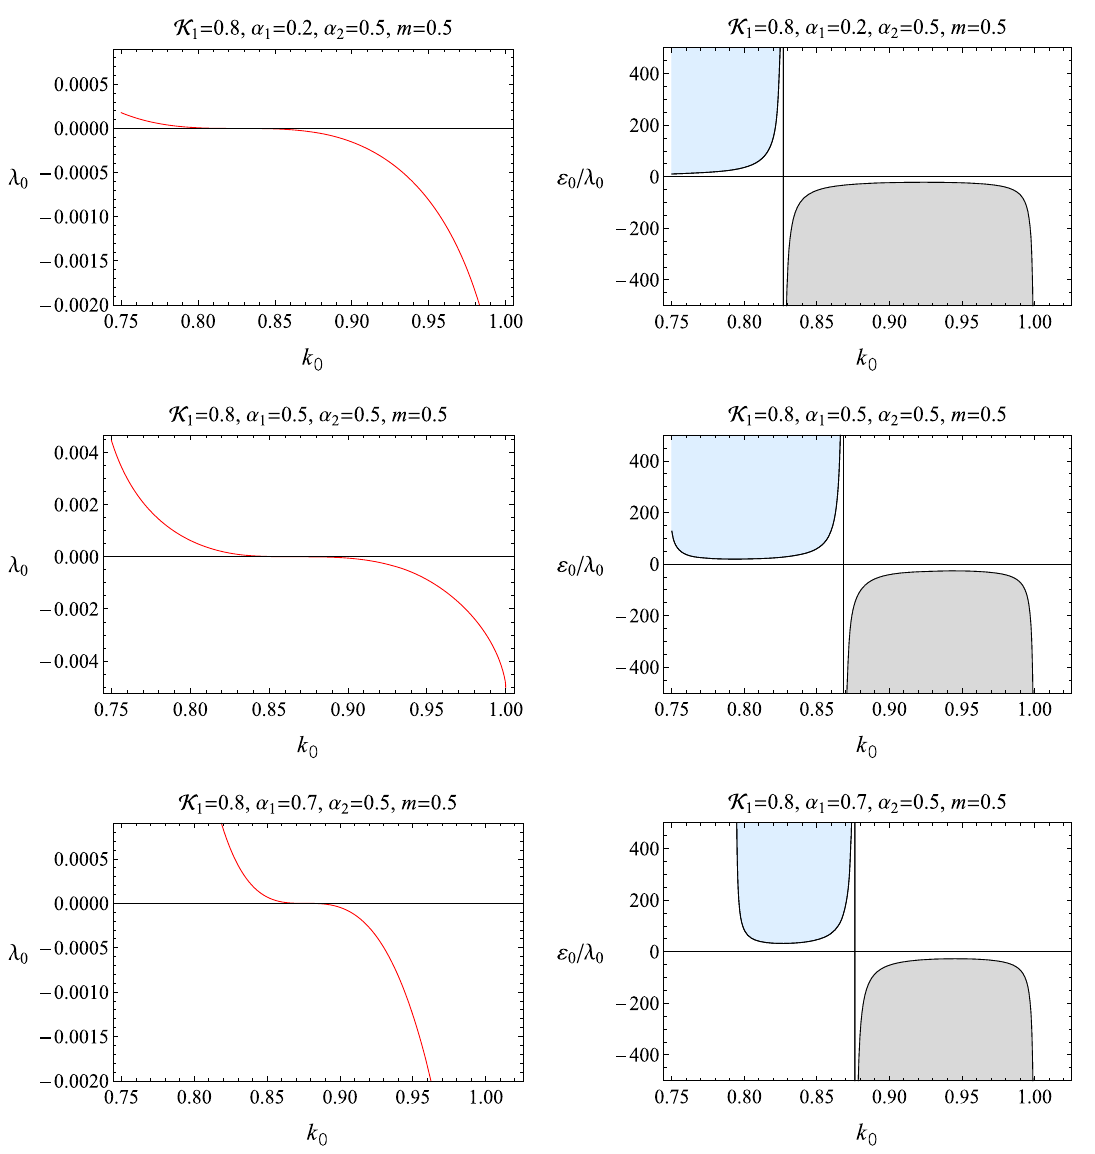
Fig. 8 Stable regions for the choice of first shape function (case(i)) for different values of α 1 . Left plots show the graphical behavior of λ 0 and right plots expressed the stable regions. The straight line in right plots